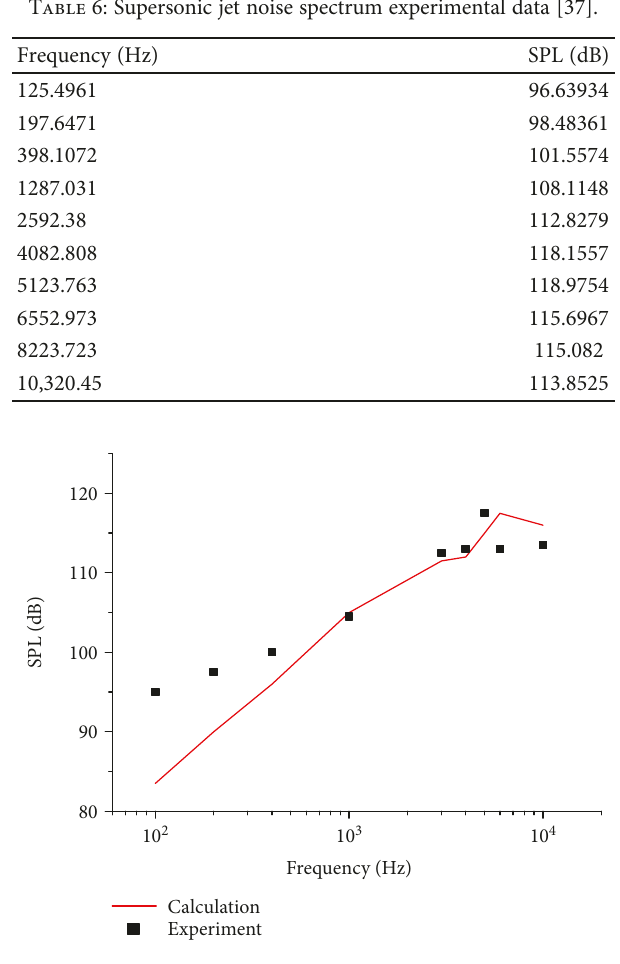
Figure 16: The check of the supersonic jet noise